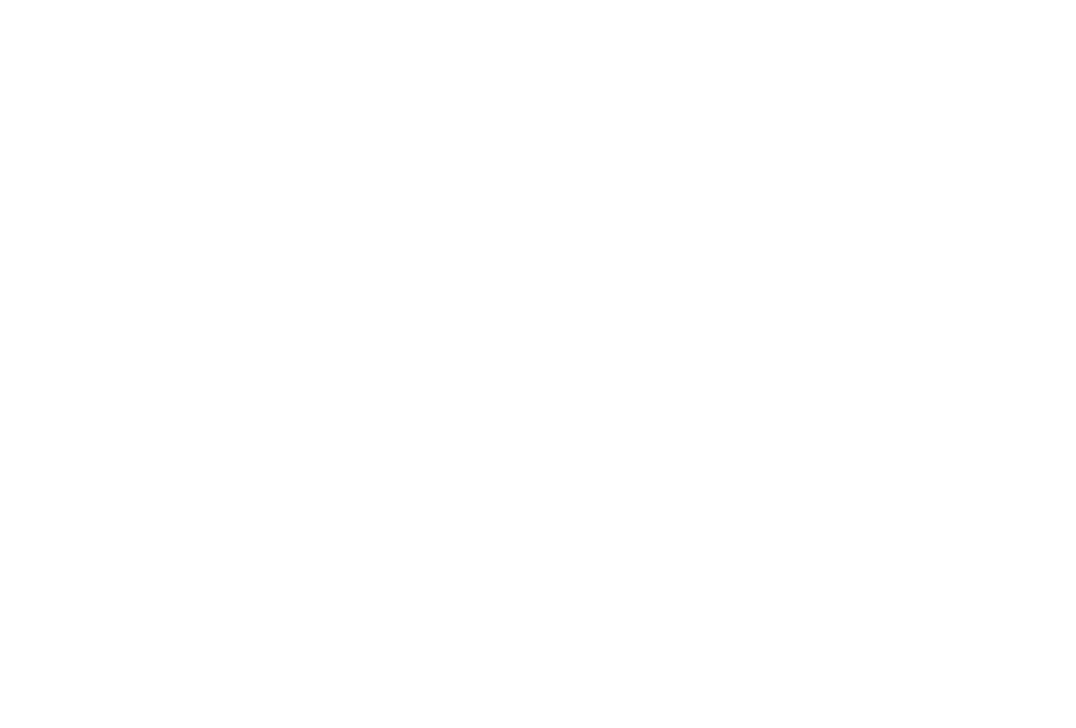
Figure 4. IC 50 ( μ M) values of 2-imino-2 H -chromen-3-yl-1,3,5-triazines 5 – 12 and 2 H -chromen-3-yl- 1,3,5-triazines 13 , 14 on five human tumor cell lines (DAN-G, A-427, LCLC, SISO, RT-4) compared to cisplatin (CDDP). 3. Experimental Section The melting points were determined with a Boëtius apparatus and are uncorrected. The infrared spectra were obtained on KBr pastilles using a Nicolet 380 FT-IR (Thermo Fisher Scientific, Waltham, MA, USA). Magnetic resonance spectra (NMR) were recorded with a Varian Gemini 200 BB (200 MHz) spectrometer (Varian Inc. Palo Alto, CA, USA) and Varian Unity Inova 500 (500 MHz) spectrometer in 200 MHZ in a DMSO- d 6 solution. The residual peak of the solvent was used as an